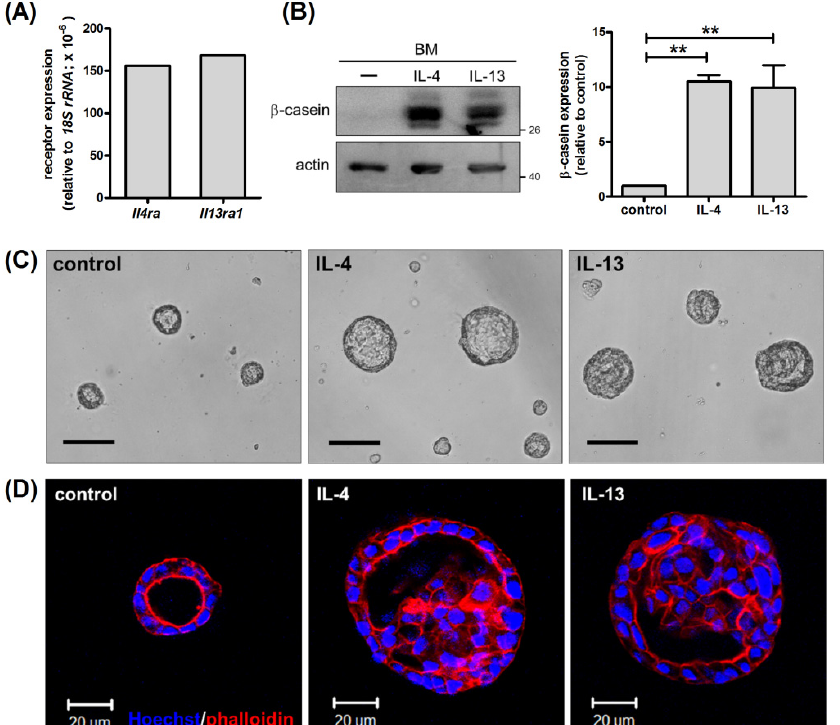
Figure 1. IL-4 and IL-13 stimulate β -casein expression and enlargement of mammary acini. Primary mouse mammary epithelial cells were cultured on a basement membrane (BM)-like matrix, Matrigel. ( A ) Expression of Il4ra and Il13ra1 mRNA was analyzed by real-time RT-PCR. ( B – D ) Cells were untreated or treated with IL-4 (50 ng/mL) or IL-13 (50 ng/mL) for 2 d. ( B ) Total cell lysates were analyzed by immunoblotting with antibodies to β -casein and actin. Actin was used as a loading control. Data were quantified, normalized to loading control and expressed as fold change relative to control ( n = 3). ** p < 0.01. ( C ) Photographs of untreated, IL-4-treated and IL-13-treated mammary acini. Scale bar, 100 µ m. ( D ) Cells were stained with rhodamine phalloidin (red) and Hoechst 33342 (blue) and subjected to confocal microscopy. Images were taken from the center of acini. Scale bar, 20 µ m. Unless otherwise noted, mammary cells were always cultured in the presence of insulin and hydrocortisone.